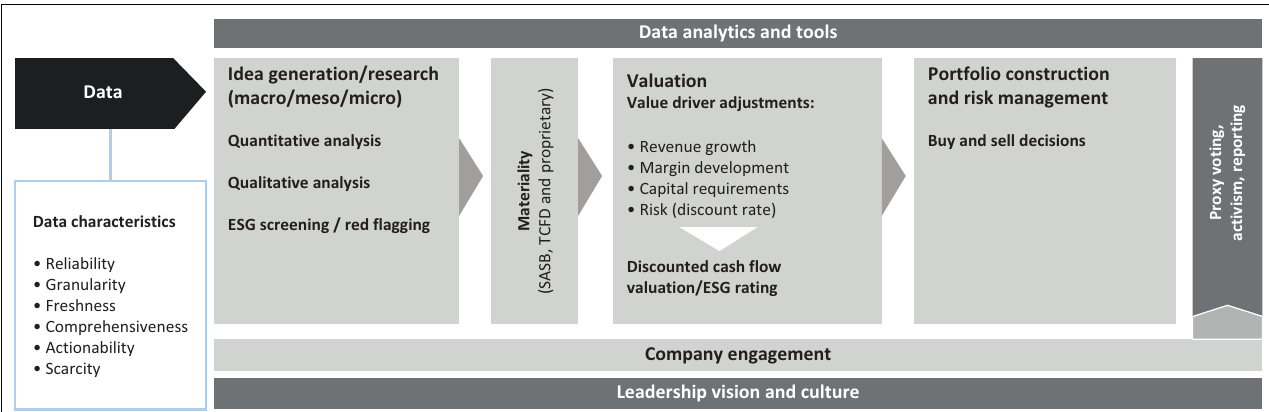
FIGURE 1: Proposed best-practice framework for environmental, social and governance